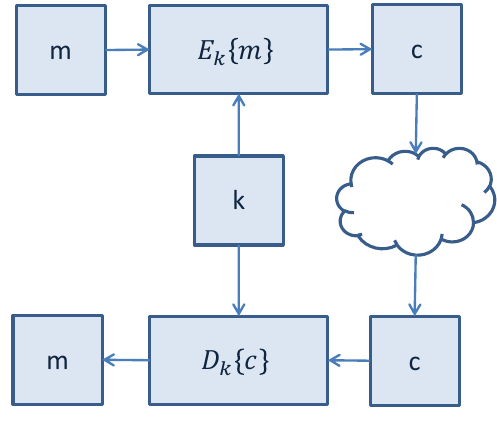
Figure 3. Secure communication with symmetric-key cryptographic